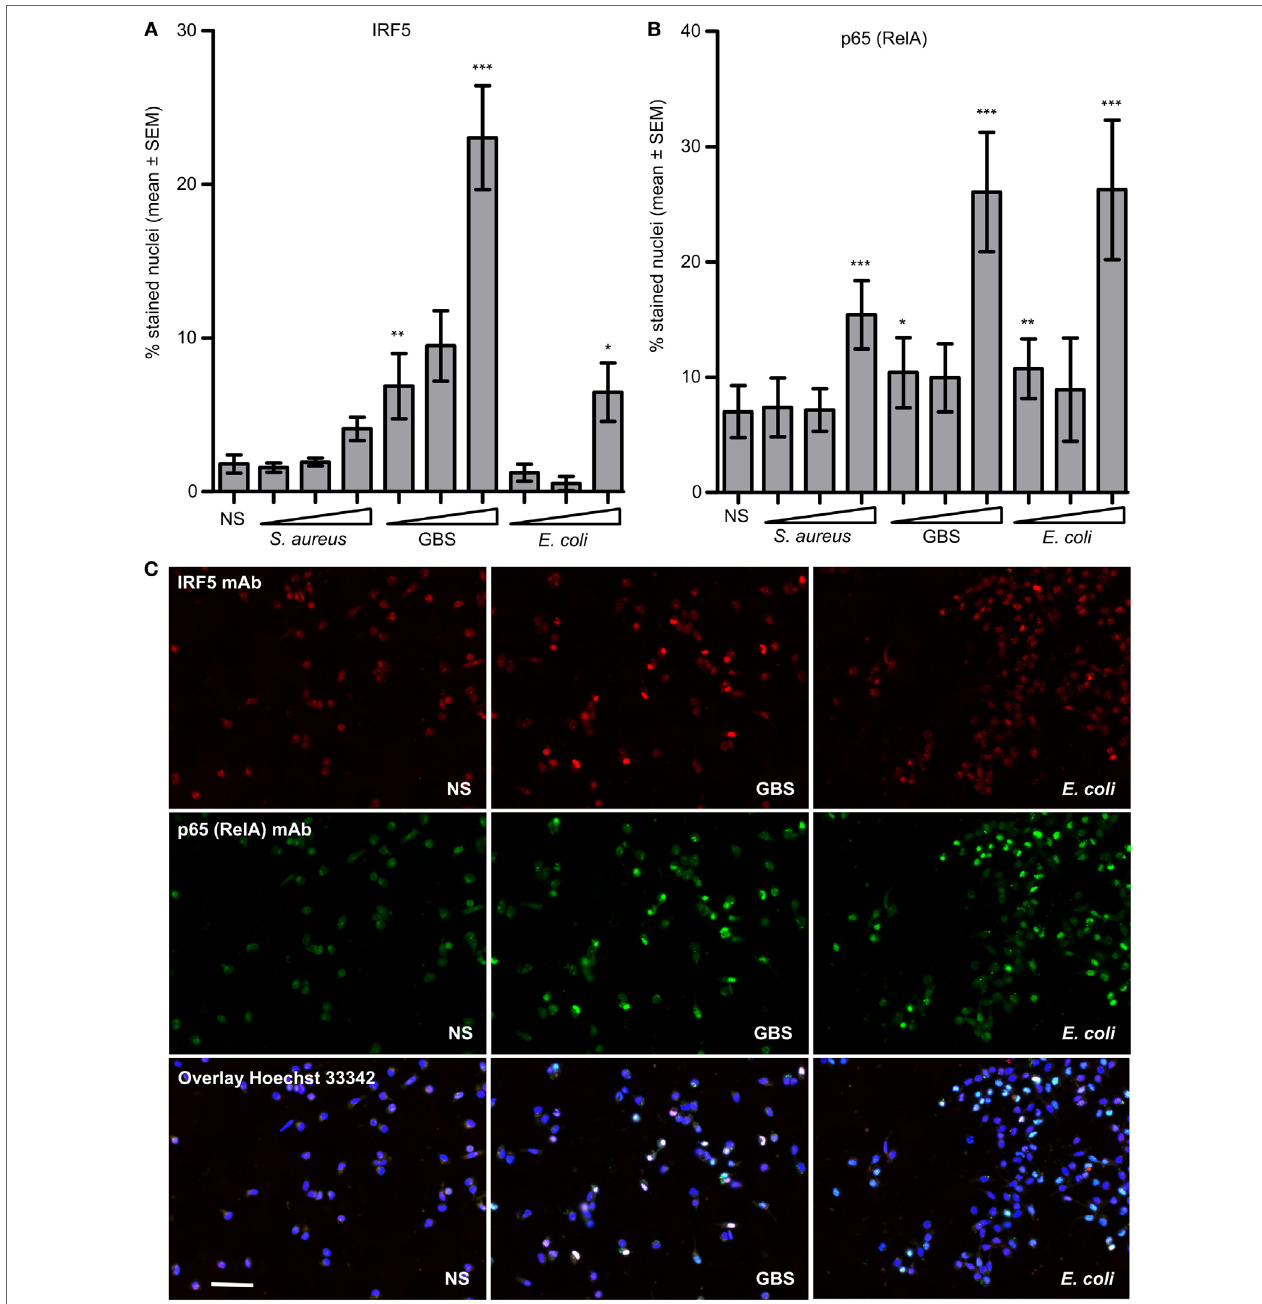
FigUre 3 | Group B Streptococcus (GBS) is a more potent activator of interferon regulatory factor 5 (IRF5) nuclear accumulation in monocytes than stationary grown Staphylococcus aureus and Escherichia coli . Monocytes were infected with viable S. aureus Cowan strain (MOI 0.20–0.64–2.00), GBS wt (MOI 0.10–0.32– 1.00), or E. coli (MOI 0.20–0.64–2.00) for 2 h. Fixation and immunofluorescence (IF) double staining of IRF5 and NF-kB (p65/RelA) was subsequently performed, and quantification was done by high-content screening (Scan^R, 20 × ). (a) Percentage of nuclei positively stained for IRF5, and (B) p65. (c) Representative images of IRF5 and p65 staining in cell with no stimuli (NS), and GBS and E. coli infected monocyte cultures (scale bar 50 µm). Significance was tested relative to NS. n = 4 ( n = 2 for the medium bacterial